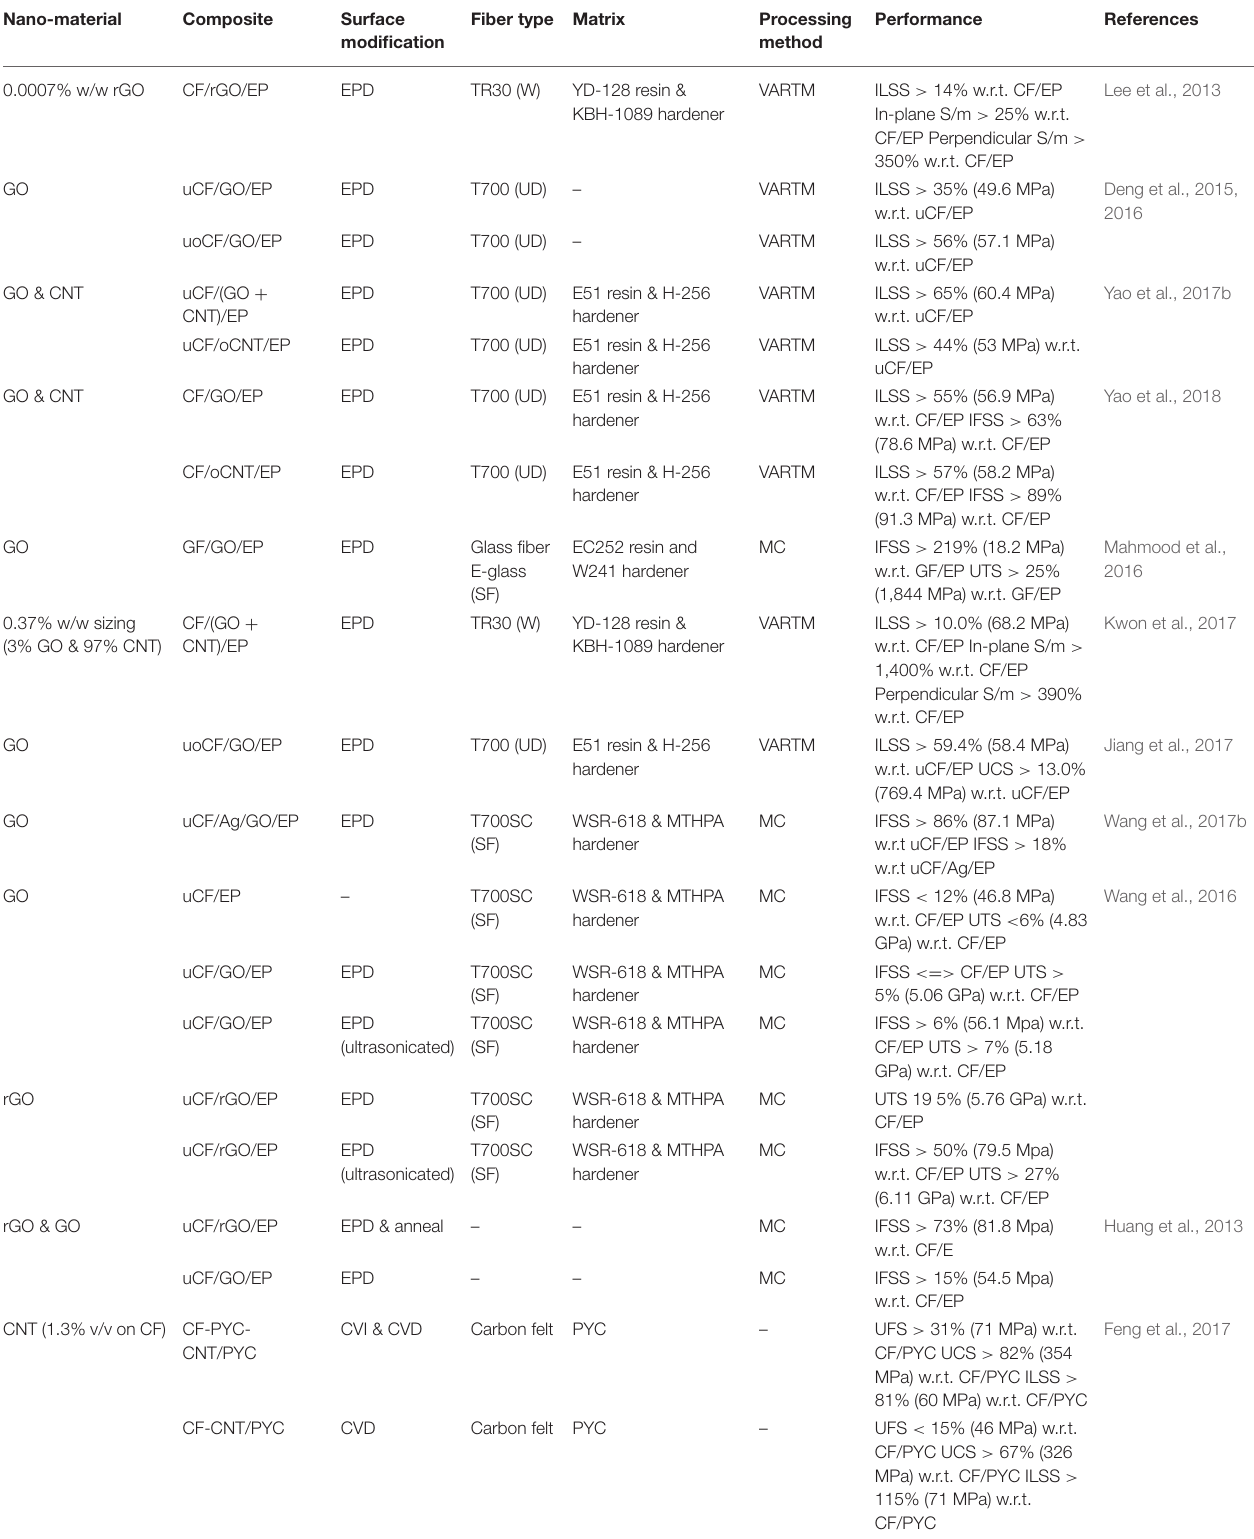
TABLE 2 | A summary of results from literature investigating electrophoretic deposition technique to modify the fiber surface properties.